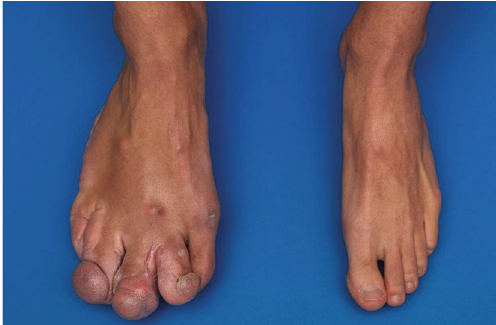
Figure 1: Photograph of the patient ’ s bilateral dorsal feet, demonstrating the hypertrophy of digits 2, 3, and 4 and bony prominence over the right 3 rd metatarsal